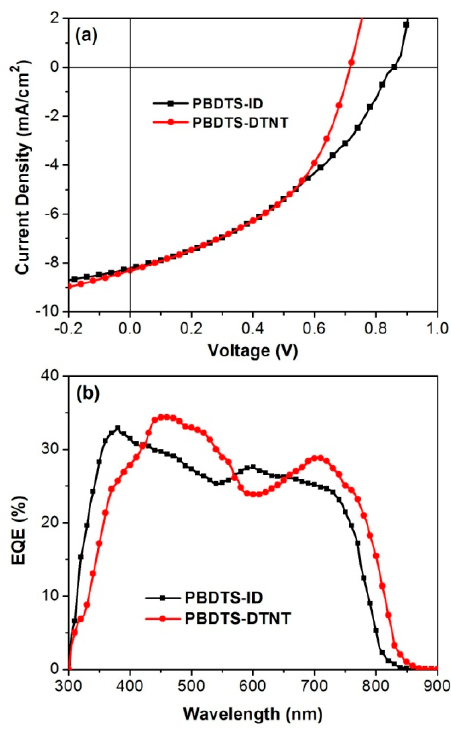
Figure 5. ( a ) J - V curves of the best-performing PSCs from the blend of the polymers and PC 71 BM; ( b ) external quantum efficiency (EQE) curves of the corresponding PSCs with 3% 1,8-diiodooctane (DIO) additive treatment.